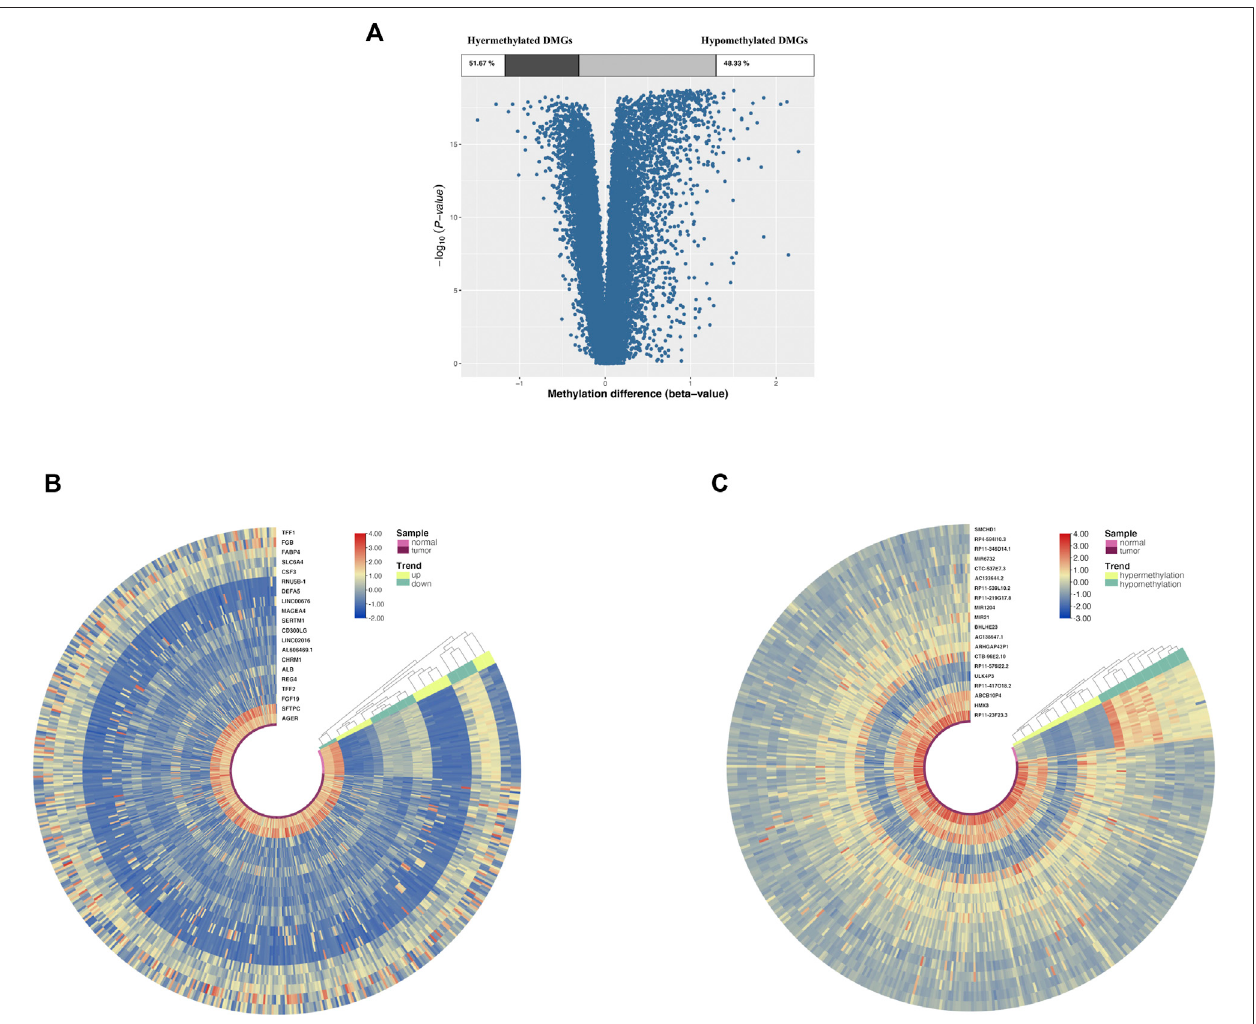
FIGURE 2 | DMG and DEG analysis in cancer and adjacent samples from LUAD patients. (A) Volcano plot of DMGs; the percentages of hypermethylated and hypomethylated DMGs are displayed on top. (B) Heatmap of top 20 DEGs (10 upregulated genes and 10 downregulated genes). (C) Heatmap of top 20 DMGs (10 hypermethylatedgenesand10hypomethylatedgenes);redindicatesthattheexpressionofgenesisrelativelyupregulated,orthelevelofmethylationishypermethylated, and blue indicated that the expression of genes is relatively downregulated, or the level of methylation is